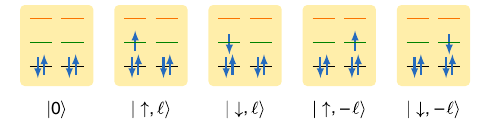
Fig. 5 Many-body groundstates. Con fi guration corresponding to the N = 0 groundstate and to the four N = 1 groundstates with one extra electron in shell m = 1. The shells denoted in the text with m = 0, 1, 2 are depicted here in black, green and orange, CNT of fi nite length is fully characterized by a shell quantum number m and the pair ð σ ; ‘ z Þ , accounting for the spin and orbital degrees of freedom. Curvature-induced spin − orbit coupling and valley mixing remove the intra-shell degeneracy. The amplitude of the spin − orbit coupling is largest near the Dirac point and of the order of a fraction of meV. However, it strongly decreases for states away from the bottom of the CNT conduction band 23 ,